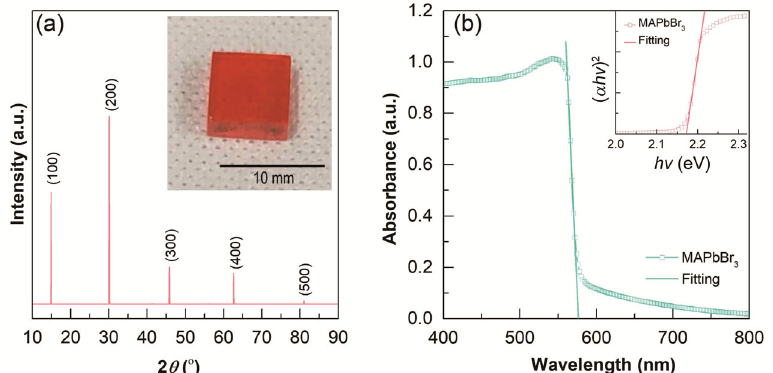
Fig. 1 (a) XRD and (b) absorption spectra of MAPbBr 3 single crystals. Inset in (a): image of one of the measured crystals grown from solution; inset in (b): absorbance versus photon energy and the determined band gap E g , where  is the absorption coefficient, h is Planck constant, and v is the frequency (a proportion of light velocity to wavelength, v = c /  ).